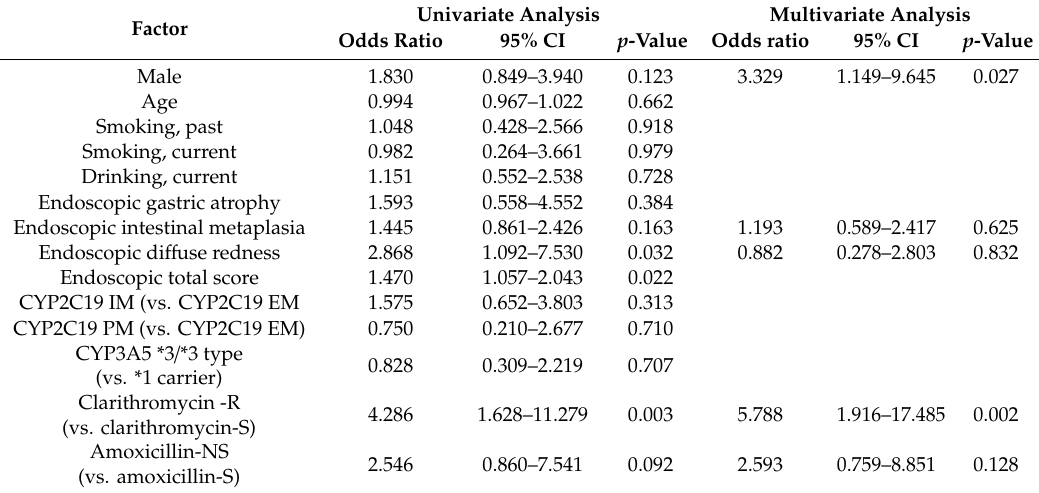
Table 3. Univariate and multivariate analyses of factors for eradication failure in first-line therapy.